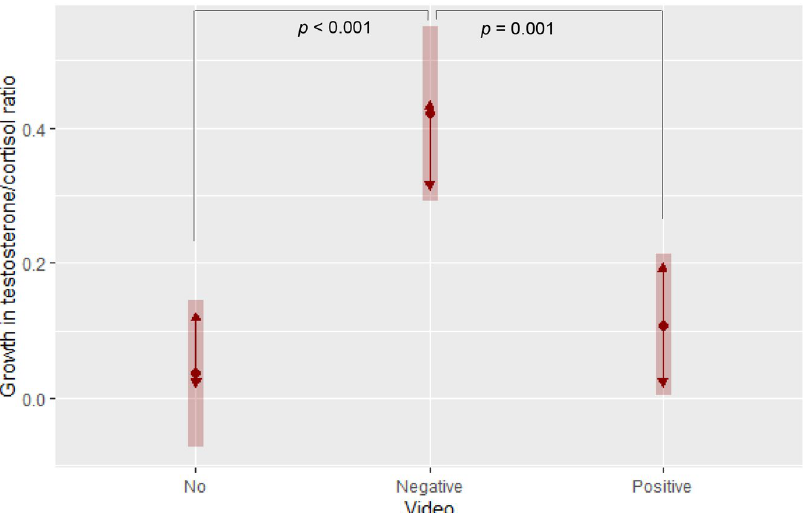
Figure 2. The physiological effects of media portrayals of immigrants (Study 1). Estimated marginal means (range 0–1) of testosterone-cortisol ratio growth rate by video conditions (Tukey adjustment for contrasts; bars: 95% confidence intervals; non-overlapping arrows: statistically significant pairwise comparison, p < 0.05). Sample: Study 1 participants.